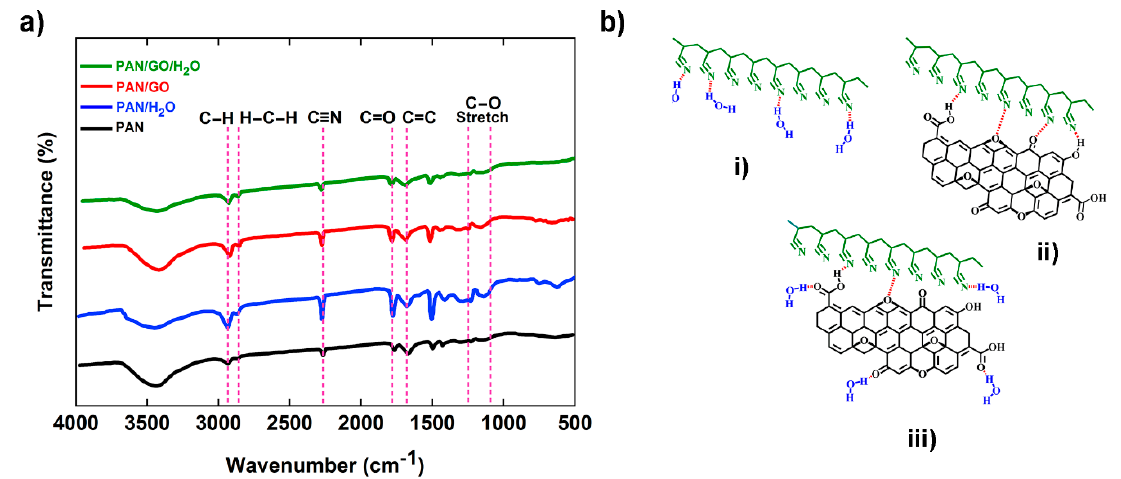
Figure 4. ( a ) FTIR spectra of PAN-based fibers, ( b ) Schematic of the interaction in (i) PAN/H 2 O composite fiber, (ii) PAN/GO composite fiber, and (iii) PAN/GO/H 2 O composite fiber.